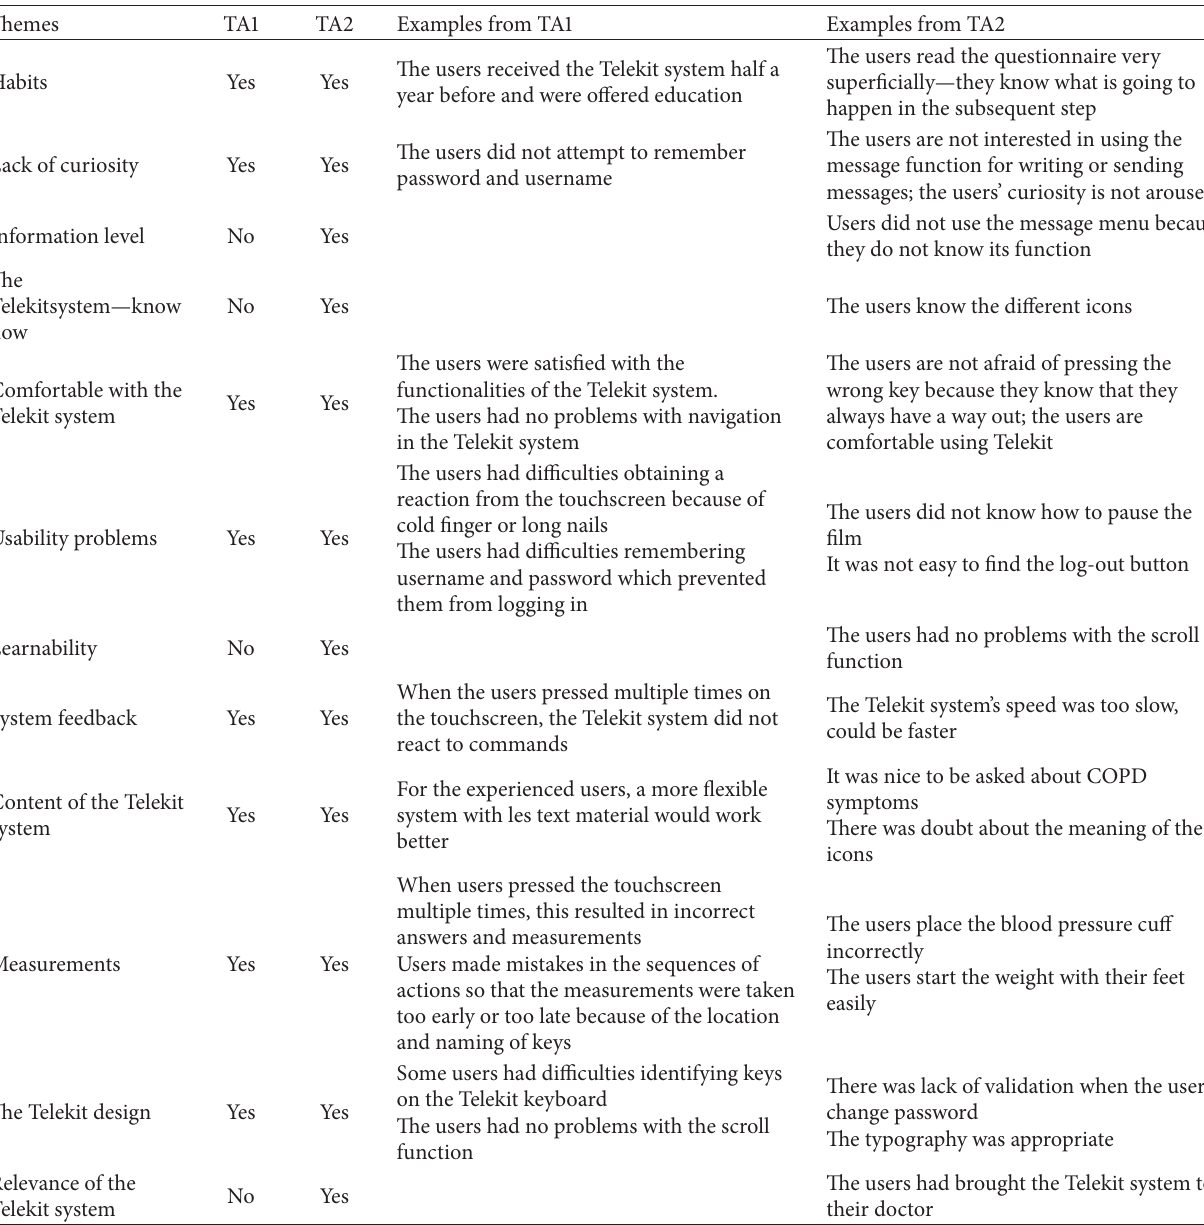
Table 5: Usability findings from the think-aloud tests were classified into 12 themes. The table illustrates the themes and the presence of themes (yes/no) and provides examples of the usability findings from TA1 and